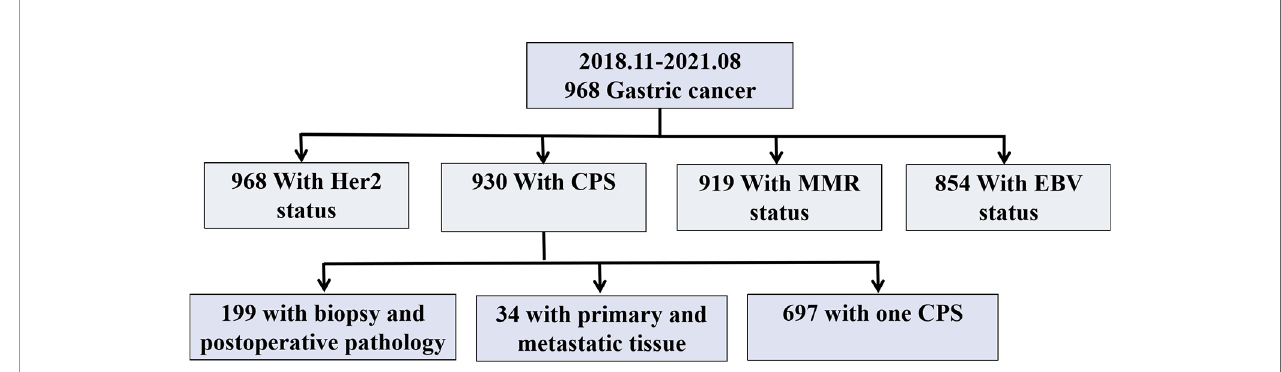
FIGURE 1 | Study Chart. Her 2, Human epidermal growth factor receptor 2; CPS, Combined Positive Score; MMR, Mismatch repair; EBV, Epstein-Barr